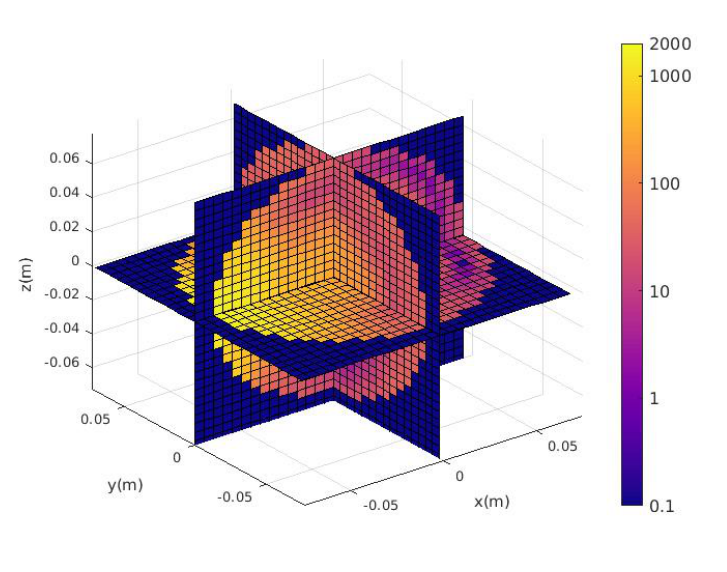
Figure 6. SAR values in brain (W/kg).